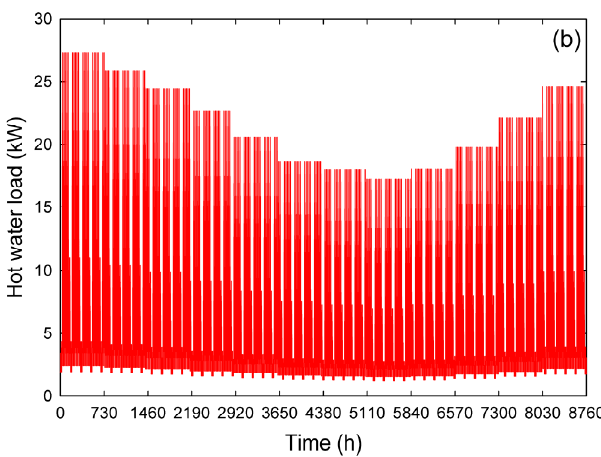
Figure 3. ( a ) Hourly hot water consumption over one day and ( b ) hot water load over one year in case study building.